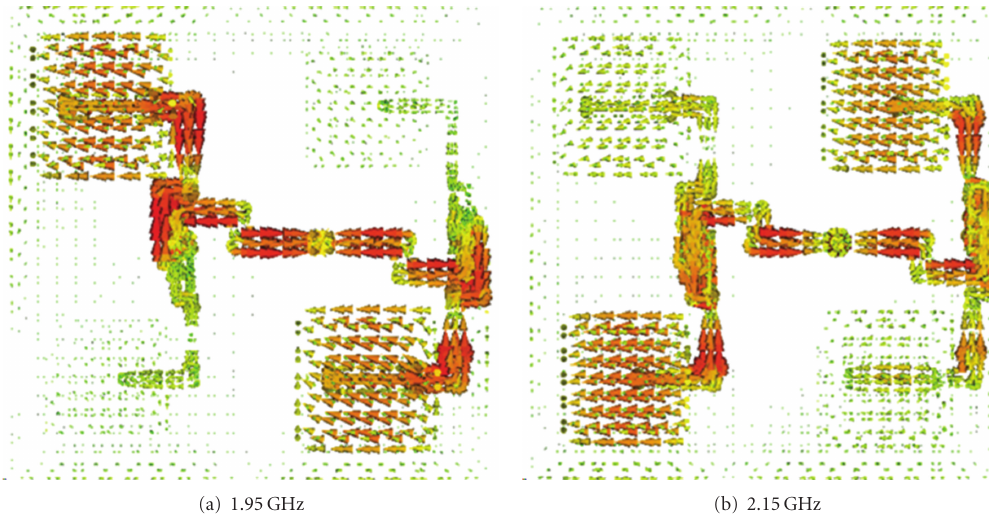
Figure 6: Simulated surface current distributions.